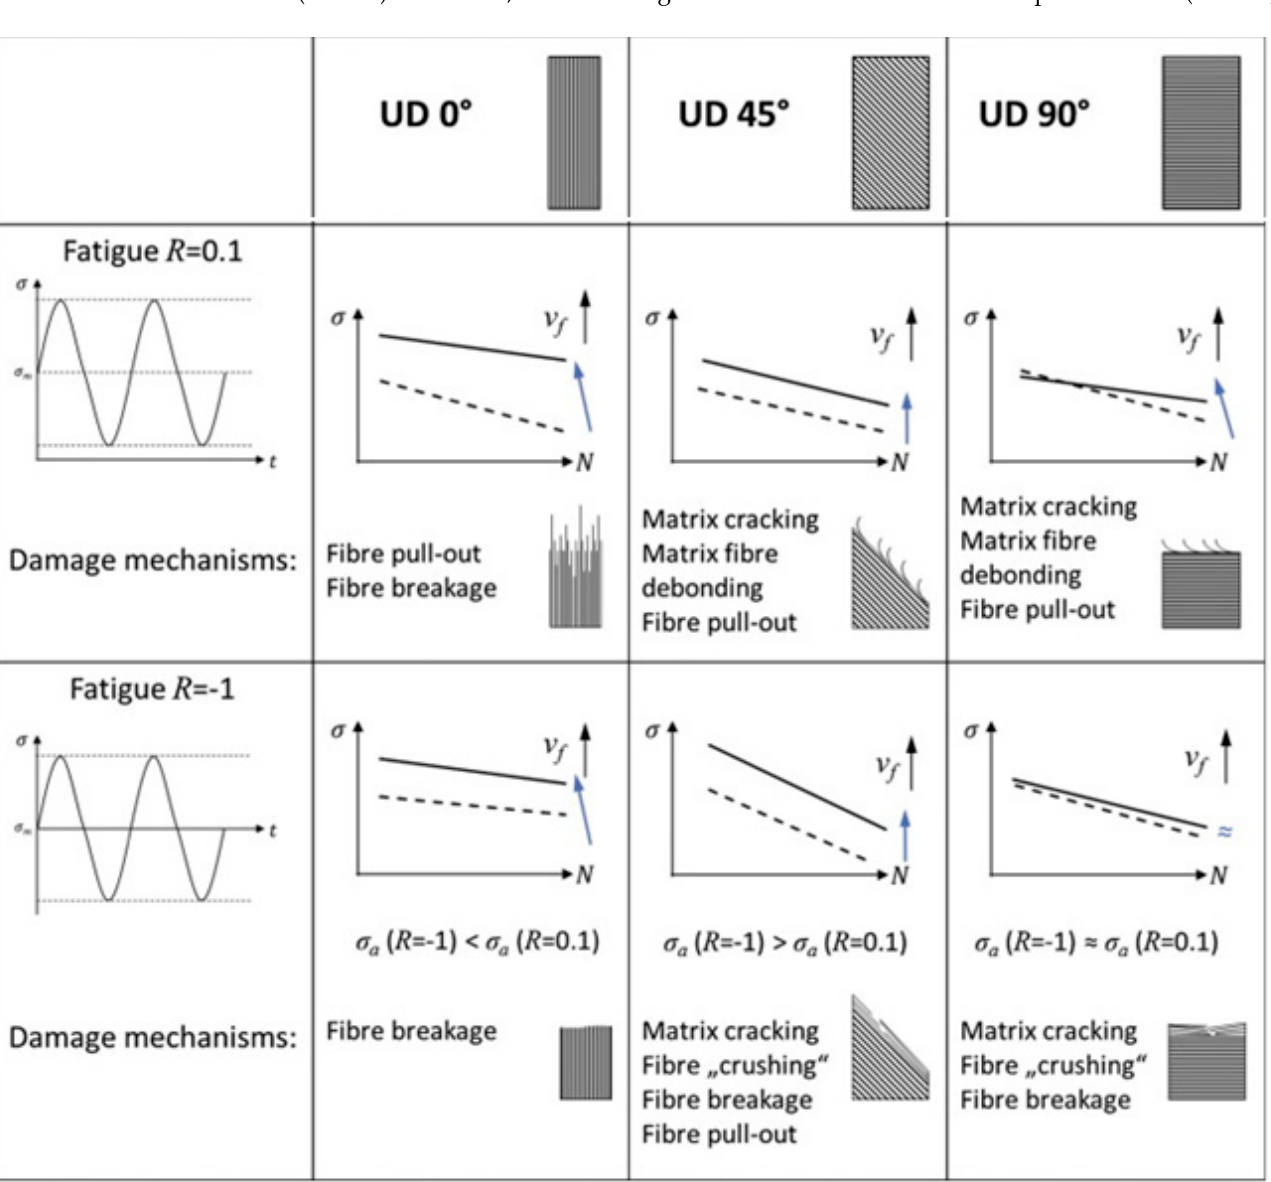
Figure 30. Schematic fatigue damage mechanisms for laminated CFRP composites depending on stress ratio, fiber volume fraction and test angle, adapted with permission from Ref. [101].